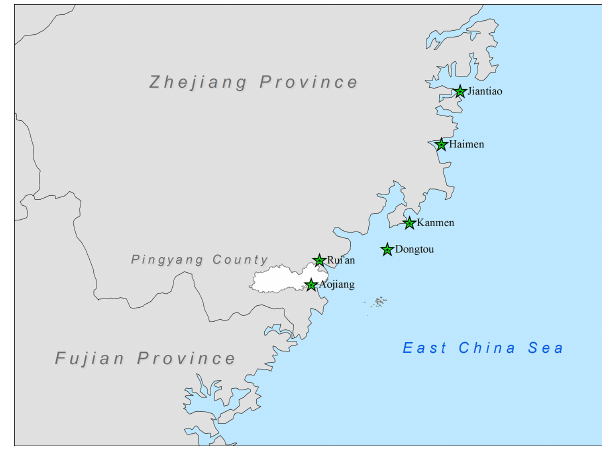
Figure 4. The distribution of tidal stations along the coastal Zhejing